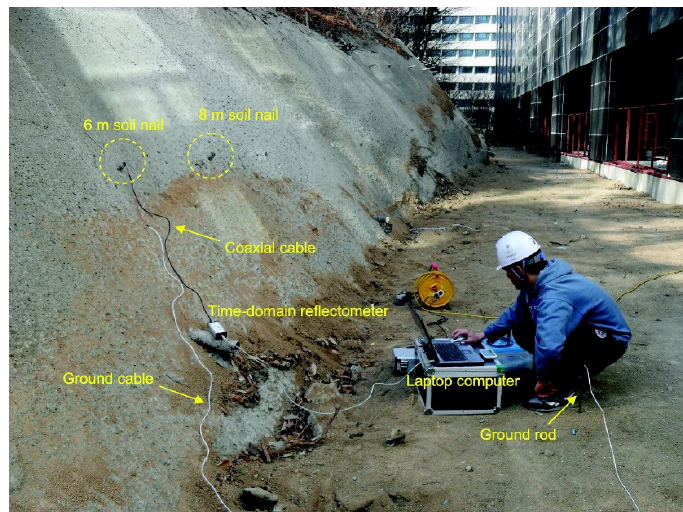
Figure 12. Experimental setup for electromagnetic wave [26].